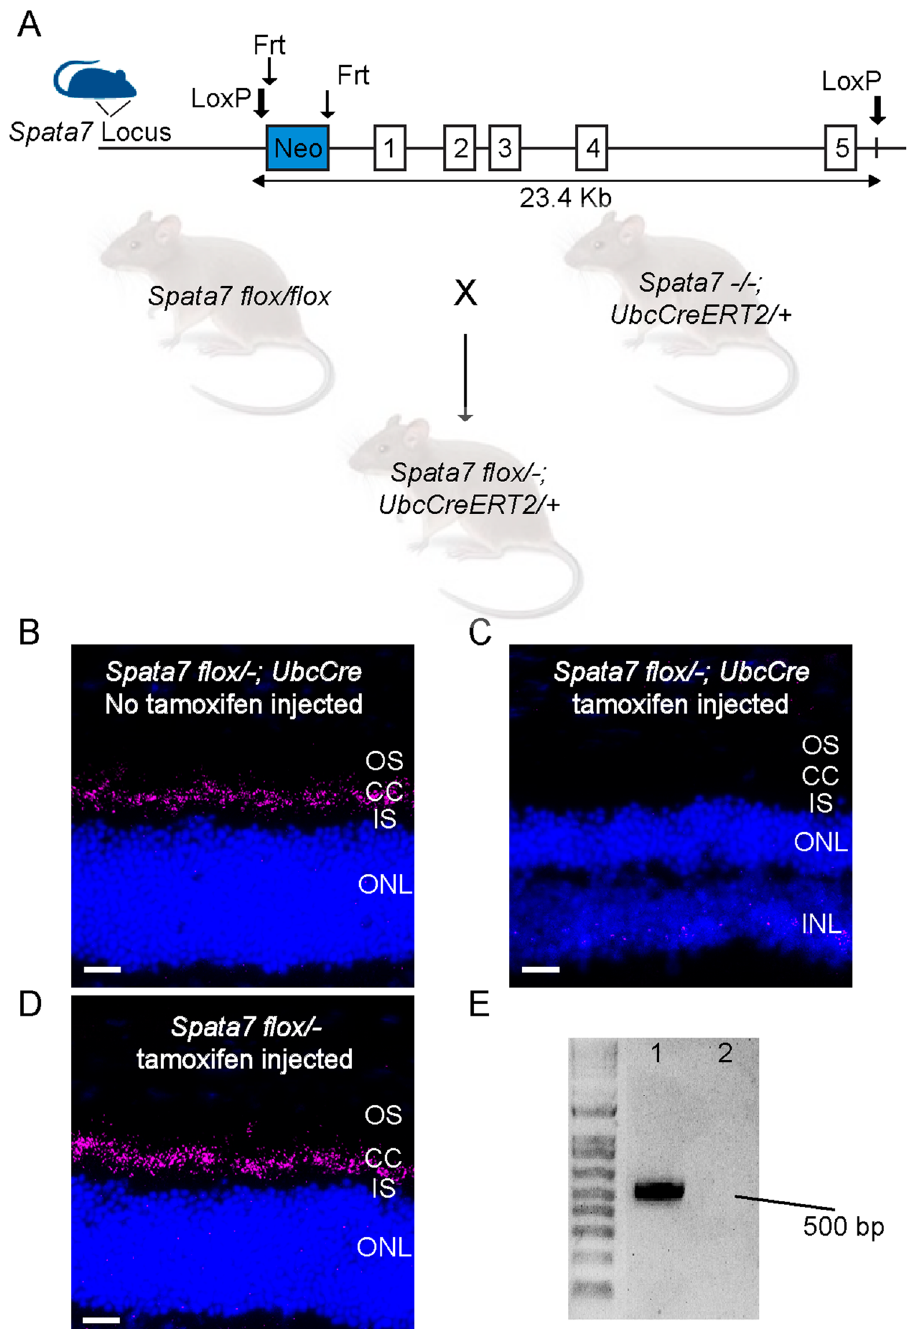
Figure 1. Loss of SPATA7 expression in retinas of Spata7 flox/− ; UbcCreERT2/ + mice. ( A ) Schematic of the Spata7 flox allele and breeding scheme for generating Spata7 flox/− ; UbcCreERT2 mice. Numbered rectangles represent Spata7 exons. ( B – D ) Anti-SPATA7 staining (pink) of retinal cryosections showing absence of Spata7 protein in 4-month-old Spata7 flox/− ; UbcCreERT2/ + mice with tamoxifen (injected at 3 months of age) ( C ) compared to non-injected Spata7 flox/− ; UbcCreERT2/ + mice ( B ) and tamoxifen-injected Spata7 flox/− mice ( D ). Nuclei are stained with DAPI (blue). INL inner nuclear layer, IS inner segment, ONL outer nuclear layer, OS outer segment, CC connecting cilium. ( E ) PCR amplification of genomic DNA shows complete deletion of the floxed portion of Spata7 following tamoxifen induction in Spata7 flox/− ; UbcCreERT2 mice. (1) Non-injected Spata7 flox/− ; UbcCreERT2 and (2) tamoxifen injected Spata7 flox/− ; UbcCreERT2 . Scale bar = 20